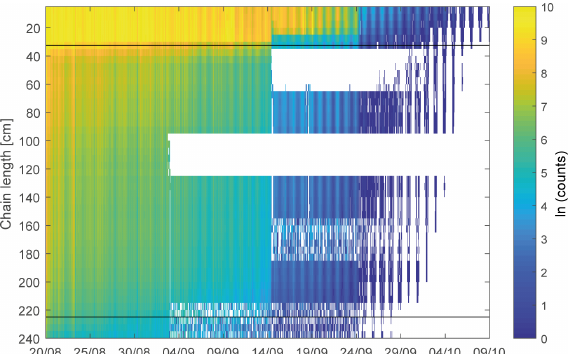
Figure 4. Data from the clear channel of the light chain, shown as the natural logarithm of sensor count after cross calibration of chain sensors. Horizontal black lines indicate the air–ice and the ice–ocean interface during deployment of the light